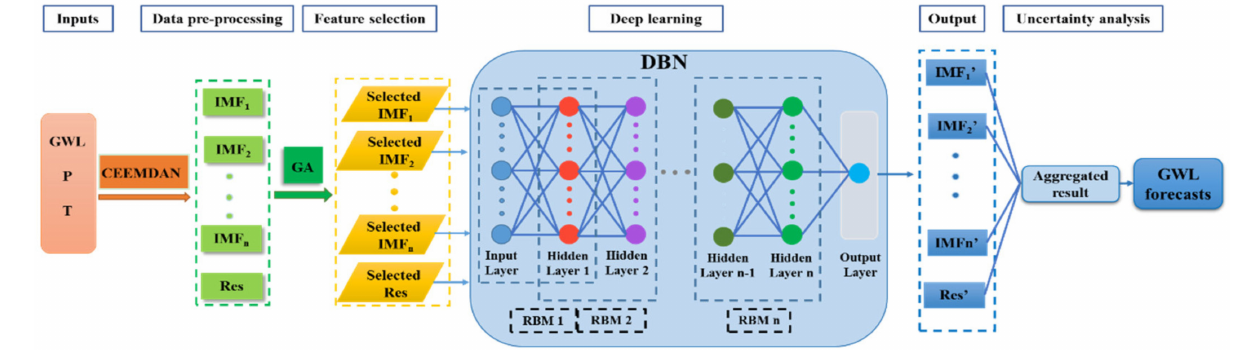
Figure 1. Schematic of the CEEMDAN-GA-DBN